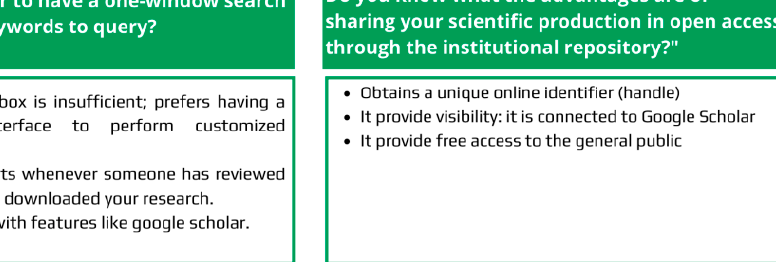
Figure 4. Results of the perceived ease for search. (Own elaboration).